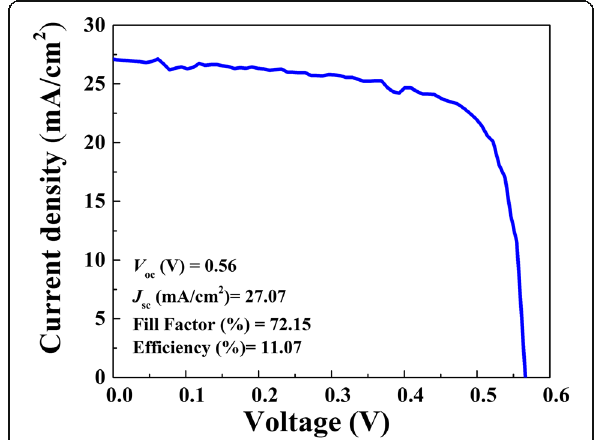
Fig. 8 J – V curves of PEDOT:PSS/n-Si hybrid solar cells with silver nanowire electrodes